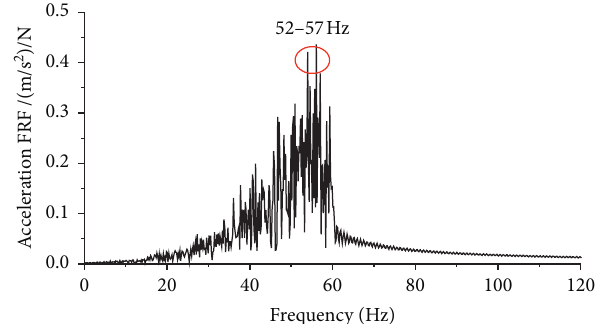
Figure 13: Vertical vibration spectrum of motor under white noise excitation.